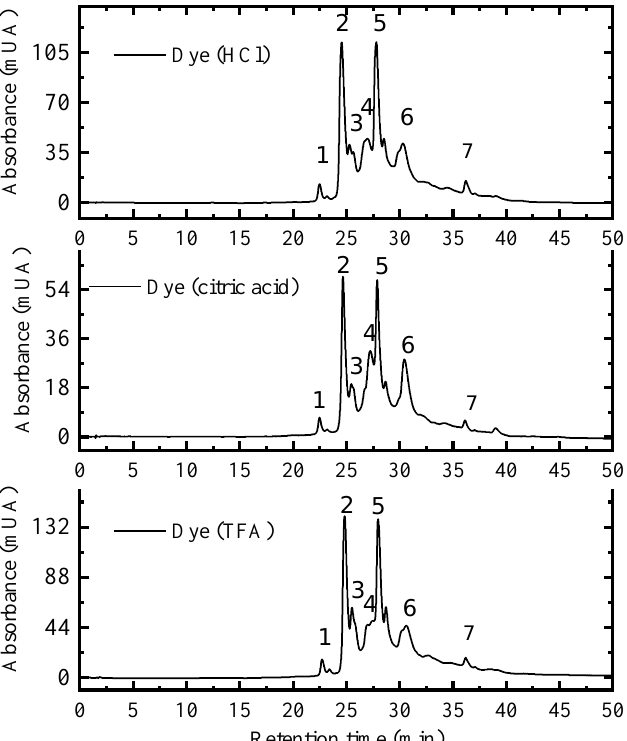
Figure 3. HPLC chromatographic profile of anthocyanins extracted with di ff erent acids from mortiño.